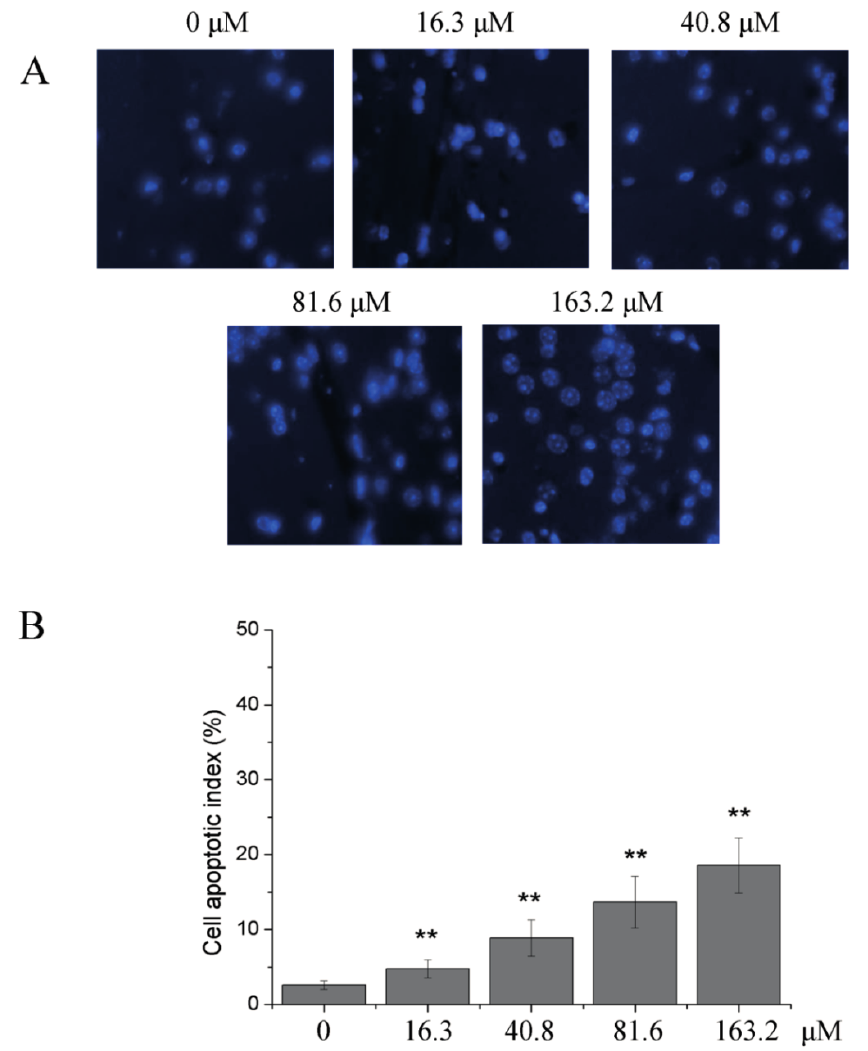
Figure 4. The effect of PD on cells apoptosis index in U251 cells. ( A ) Hoechst 33258 staining (×200); ( B ) cell apoptosis index. U251 cells were treated with 0, 16.3, 40.8, 81.6 and 163.2 μ M of PD for 48 h. Then they were stained with Hoechst 33258. Each value